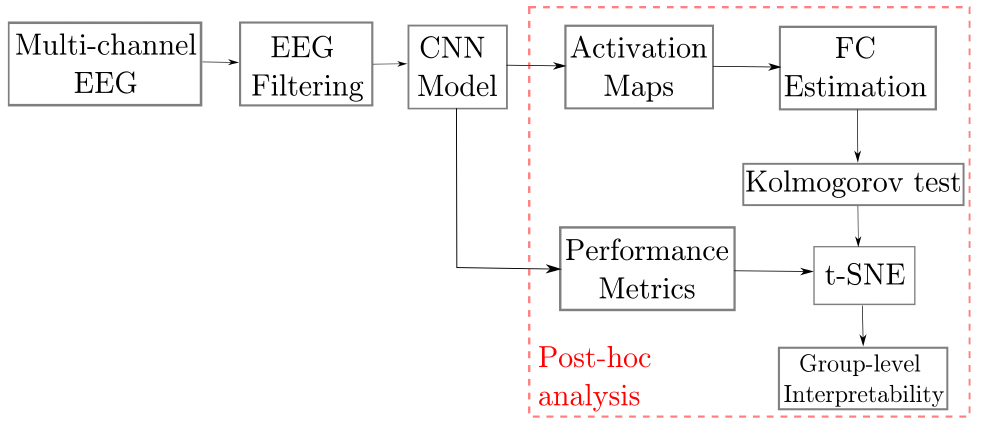
Figure 2. Guideline of the proposed framework for enhanced post-hoc interpretability of MI neu- ral responses using connectivity measures extracted from EEGNet CAMs and clustering subjects, according to the EEG MI